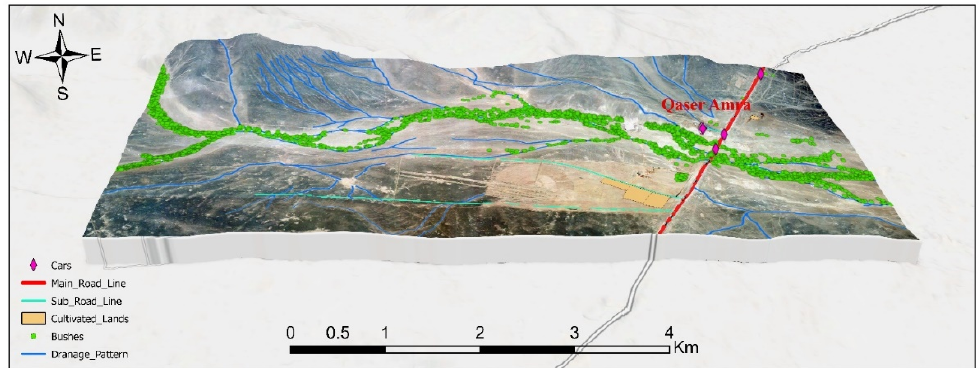
Figure 20. 3D scene of the DTM and orthophoto with the digitized castle and main GIS features.